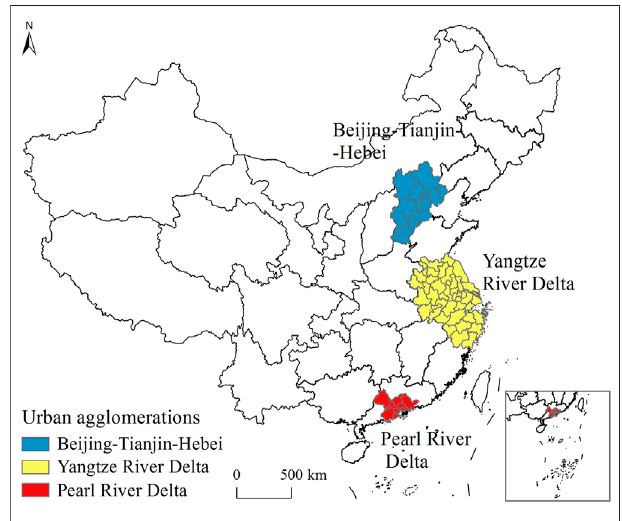
FIGURE 1 | Location of the study area and member cities in